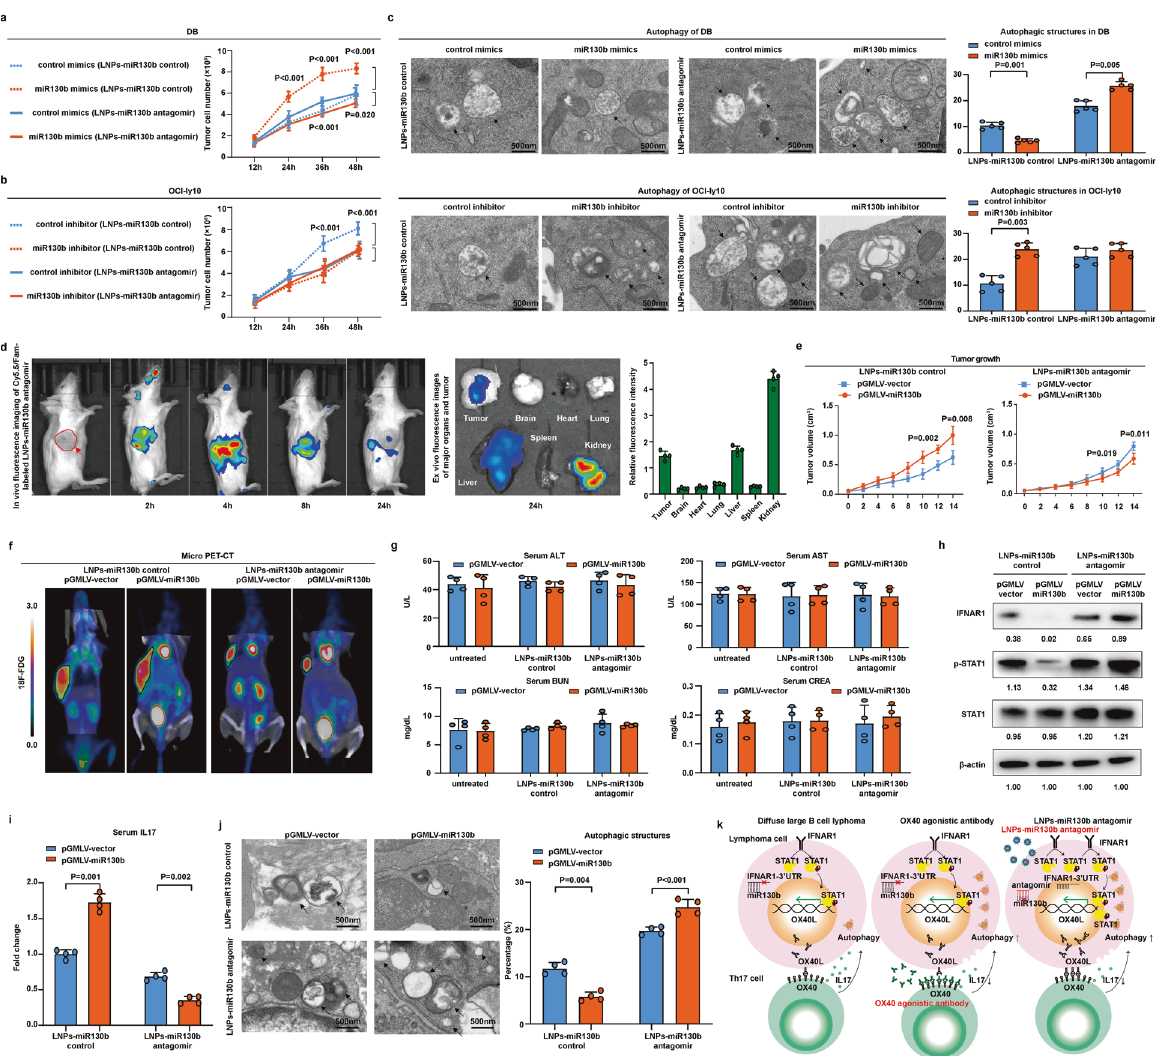
Fig. 6 LNPs-miR130b antagomir exhibited in vitro and in vivo activity on OX40-impaired B-cell lymphoma. a Cell growth in the control mimics-transfected DB co-culture system and miR130b mimics-transfected DB co-culture system upon treatment with LNPs-miR130b control or with LNPs-miR130b antagomir. MTT assay was adopted to measure cell viability. Data are summarized as mean ± SD ( n = 3). b Cell growth in the control inhibitor-transfected OCI-ly10 co-culture and miR130b inhibitor-transfected OCI-ly10 co-culture upon treatment with LNPs- miR130b control or with LNPs-miR130b antagomir. Cell viability was measured by MTT. Data are summarized as mean ± SD ( n = 3). c Transmission electron microscope showed typical autophagosomes in the miR130b mimics-transfected DB co-culture system and miR130b inhibitor-transfected OCI-ly10 co-culture upon treatment with LNPs-miR130b control or LNPs-miR130b antagomir. The cells were counted from fi ve visions selected at random and subjected for statistical analysis. Data are summarized as mean ± SD ( n = 5). d Standardized uptake value intensity of Cy5.5/Fam-labeled LNPs-miR130b antagomir after intravenous injection (left panel) were measured by micro PET-CT. The column indicated ex vivo fl uorescence images of the tumor and major organs, including brain, heart, lung, liver, spleen, and kidney, from mice at 24 h after intravenous injection (right panel). e pGMLV-vector and pGMLV-miR130b cells were injected into nude mice subcutaneously with LNPs-miR130b control or LNPs-miR130b antagomir treatment, and tumor volume was determined. Data are summarized as mean ± SD ( n = 4). f Micro PET-CT showed standardized uptake value intensity in pGMLV-vector group and pGMLV-miR130b group upon treatment with LNPs- miR130b control or LNPs-miR130b antagomir. g Serum ALT, AST, and Serum BUN, CREA were measured using a clinical chemistry analyzer in pGMLV-vector group and pGMLV-miR130b group between untreated group and treatment with LNPs-miR130b control group or LNPs- miR130b antagomir group. Data are summarized as mean ± SD ( n = 4). h Western blot analysis of IFNAR1, p-STAT, STAT1 in pGMLV-vector group and pGMLV-miR130b group upon treatment with LNPs-miR130b control or LNPs-miR130b antagomir. i IL17 level was measured by ELISA in pGMLV-vector group and pGMLV-miR130b group upon treatment with LNPs-miR130b control or LNPs-miR130b antagomir. Data